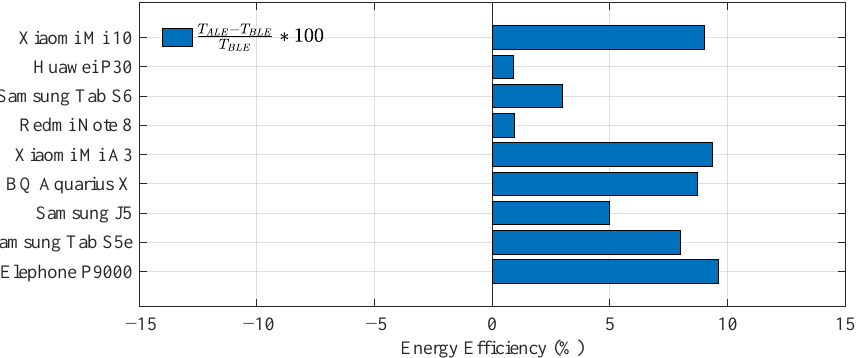
Figure 11. Energy balance of Bluetooth Low Energy (BLE) and Acoustic Low Energy (ALE) beacon scanning with each